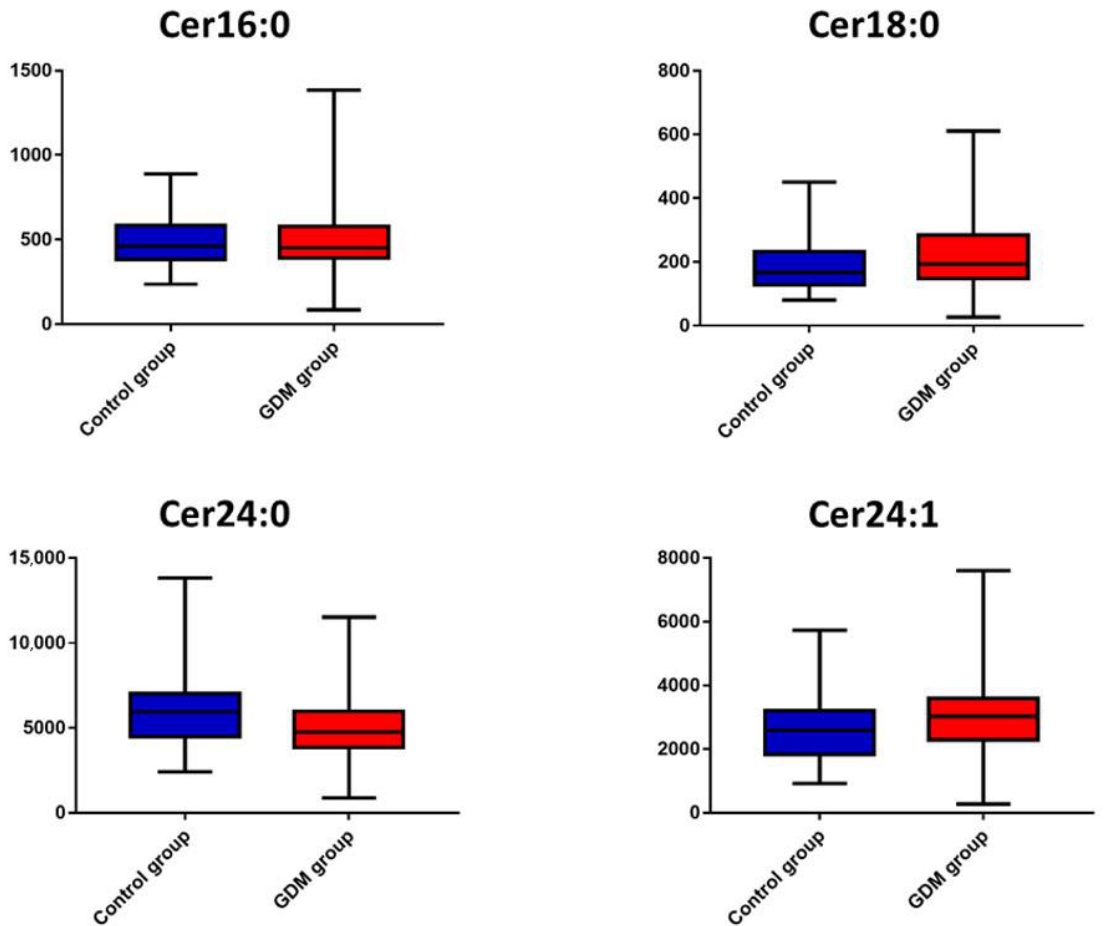
Figure 1. Box plots of the four measured ceramides in GDM (red) and control (blue) groups. Furthermore, possible correlations between the serum concentration of ceramides with several parameters (maternal, delivery, neonatal, blood pressure, biochemistry) were investigated. No significant associations were found in the cohort of studied women (GDM and control groups) (Table 3) or the GDM (Supplementary Table S1) or control group (Supplementary Table S2)